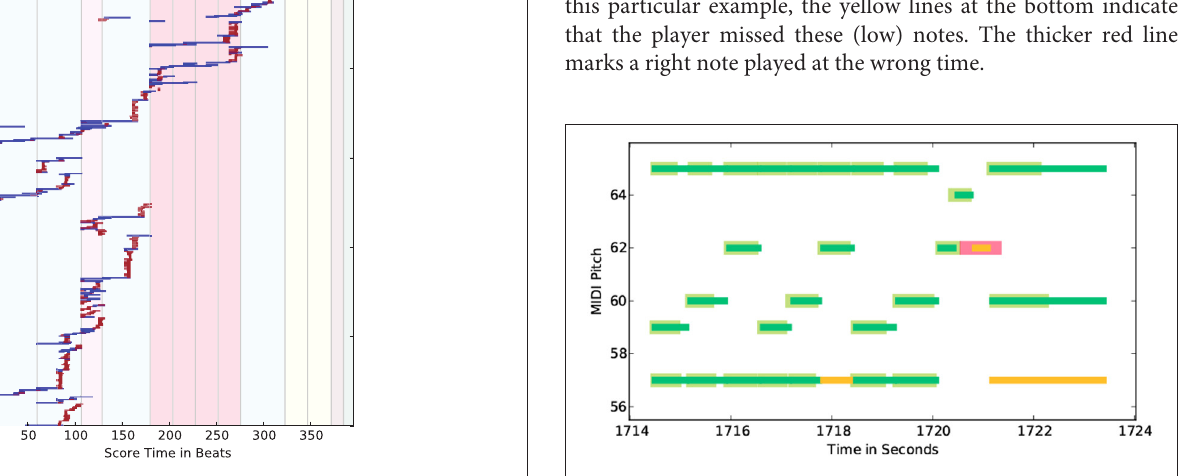
FIGURE 4 | Piano-roll representation augmented with playing accuracy information for segment No.313 from expert player (E-1). Thin green lines represent notes from the score, thick green lines notes played, thin yellow lines skipped notes, thick red lines incorrect